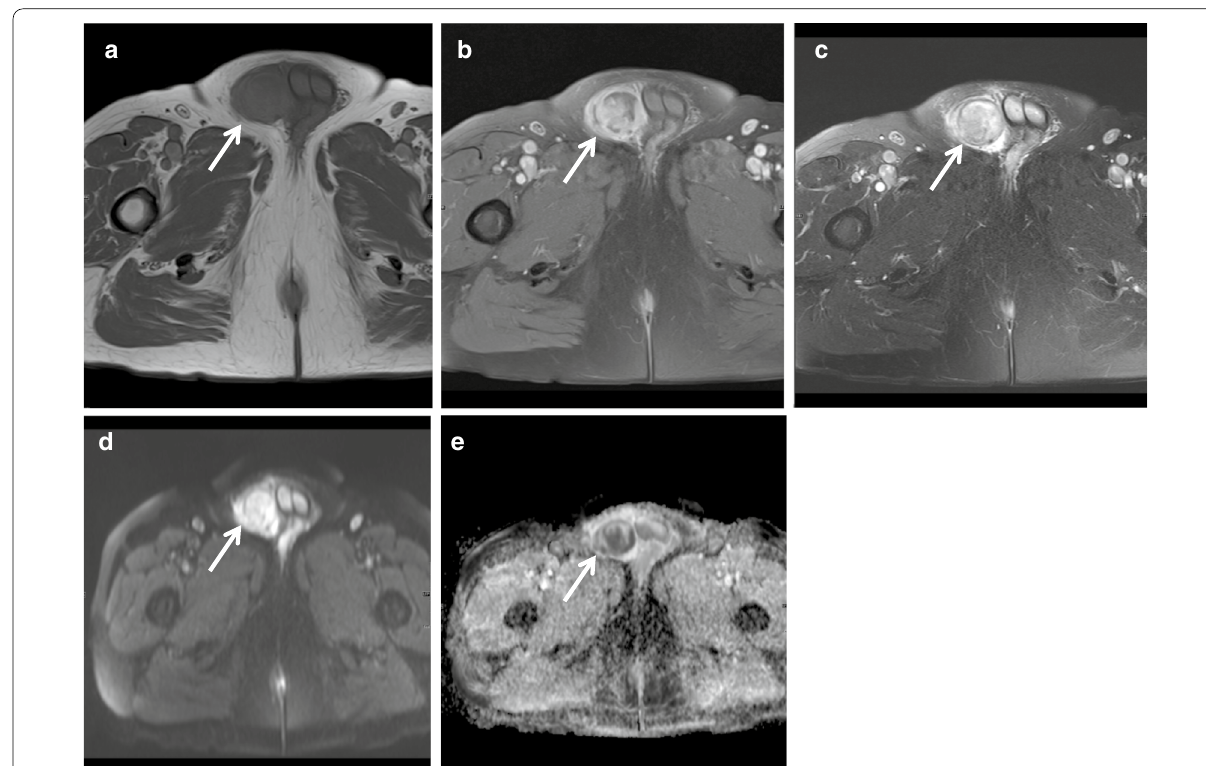
Fig. 18 Spermatic cord lymphoma a Axial T1W image shows a mass within the right inguinal canal (white arrow) which is inseparable from the spermatic cord and is mildly hyperintense to gluteus muscle and shows heterogeneous post-contrast enhancement on ( b ) T1 fat saturation and ( c ) T2 fat saturation sequences. In d and e axial DWI/ ADC, the right inguinal mass shows restricted diffusion. This was surgically excised and proven to be spermatic cord